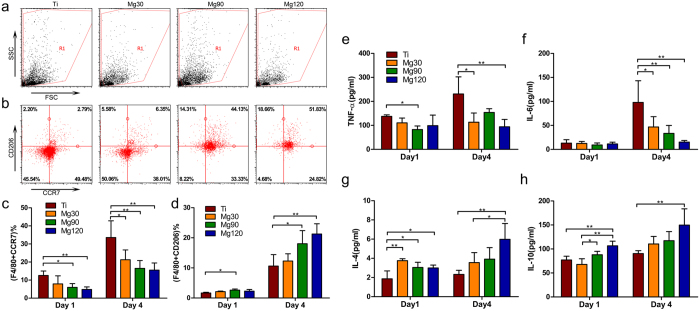
Flow cytometry analysis of cell surface markers on macrophages harvested from the mouse air pouches; cytokines in the air-pouch exudates, as determined by ELISA.Representative dot plots showing: (a) forward scatter (FSC) and side scatter (SSC), (b) expression of CCR7 (M1) and CD206 (M2) antigens. Macrophages were gated by F4/80-positive. (c) Percentage of F4/80 and CCR7 double-positive cells (M1), (d) Percentage of F4/80 and CD206 double-positive cells (M2). Cytokine production: (e) TNF-α, (f) IL-6, (g) IL-4, (h) IL-10. (Statistically significant difference: *p < 0.05; **p < 0.01; triplicate).